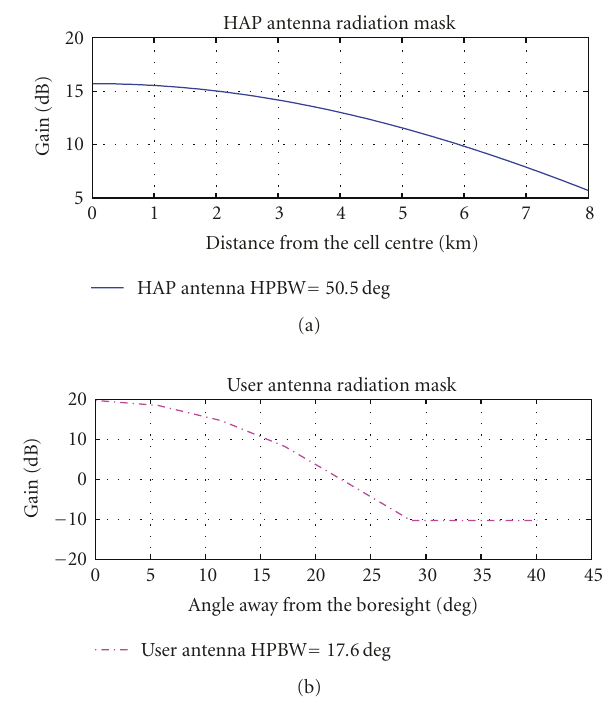
Figure 4: HAP and user antenna radiation